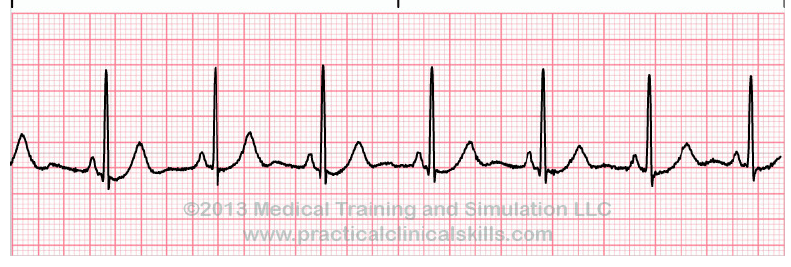
Figure 1. Normal sinus rhythm (NSR) [21].